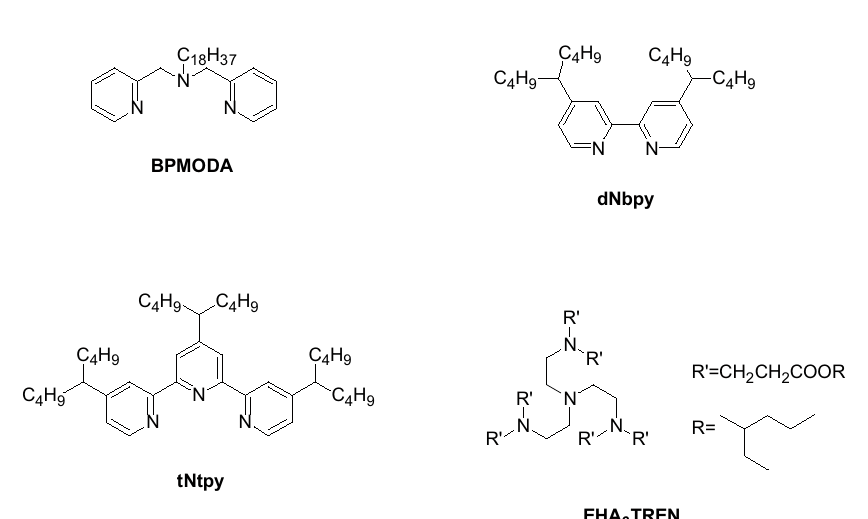
Scheme 3. Structures of common ligands used for ATRP in aqueous dispersed